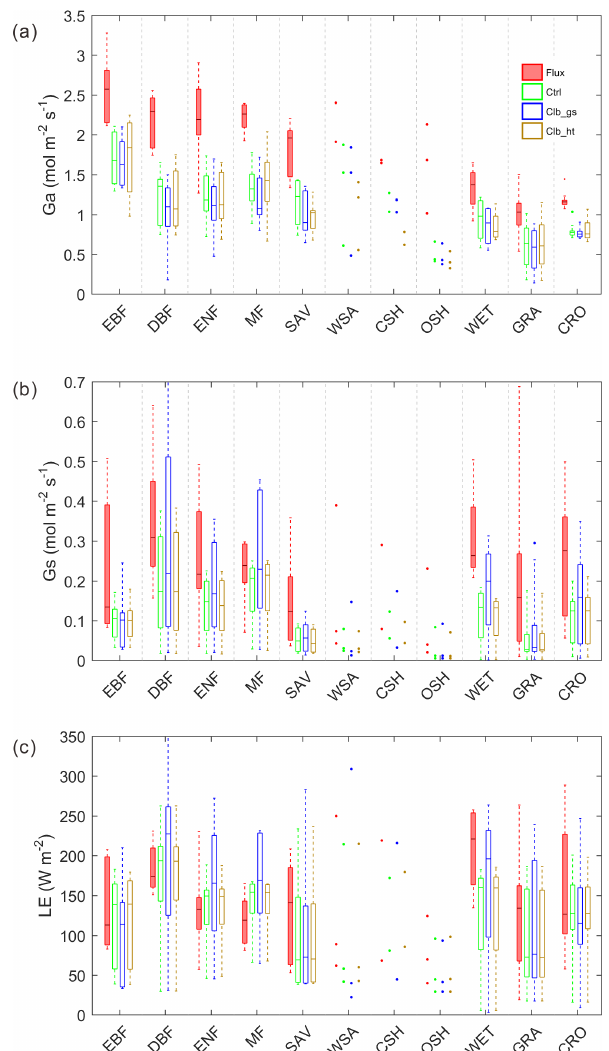
Figure 3. Same as Fig. 2 but for (a) aerodynamic conductance, (b) surface conductance and (c) latent